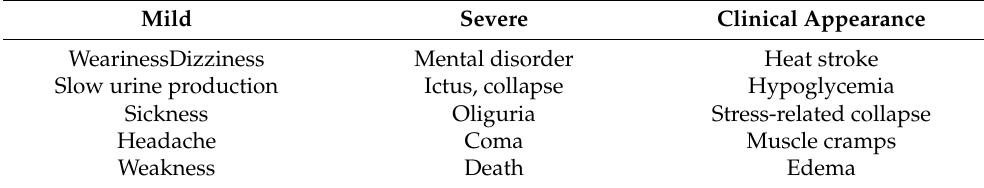
Table 4. Symptoms of EAH